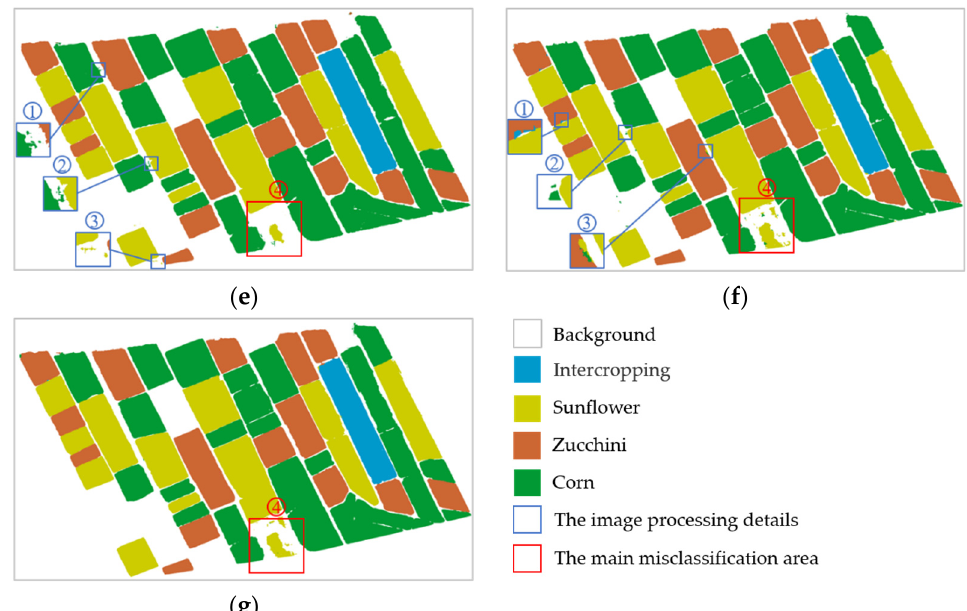
Figure 9. Comparison of classification results of different methods on test area 1. ( a ) Orthoimage, ( b ) ground truth, ( c ) PSPNet, ( d ) DeepLabV3+, ( e ) DNLNet, ( f ) OCRNet, and ( g ) the proposed method.